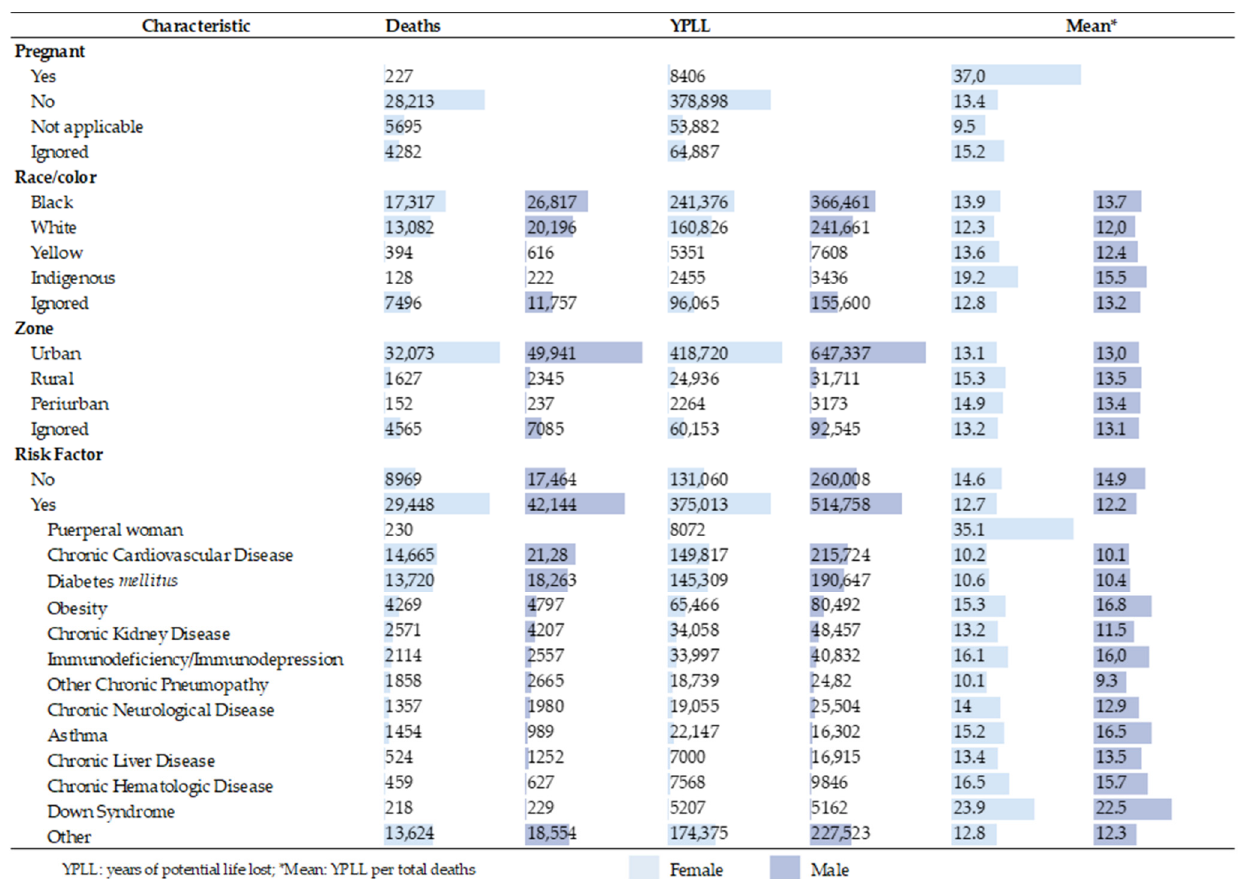
Figure 2. Deaths and years of potential life lost due to COVID-19 in Brazil (2020) by gender and age group.